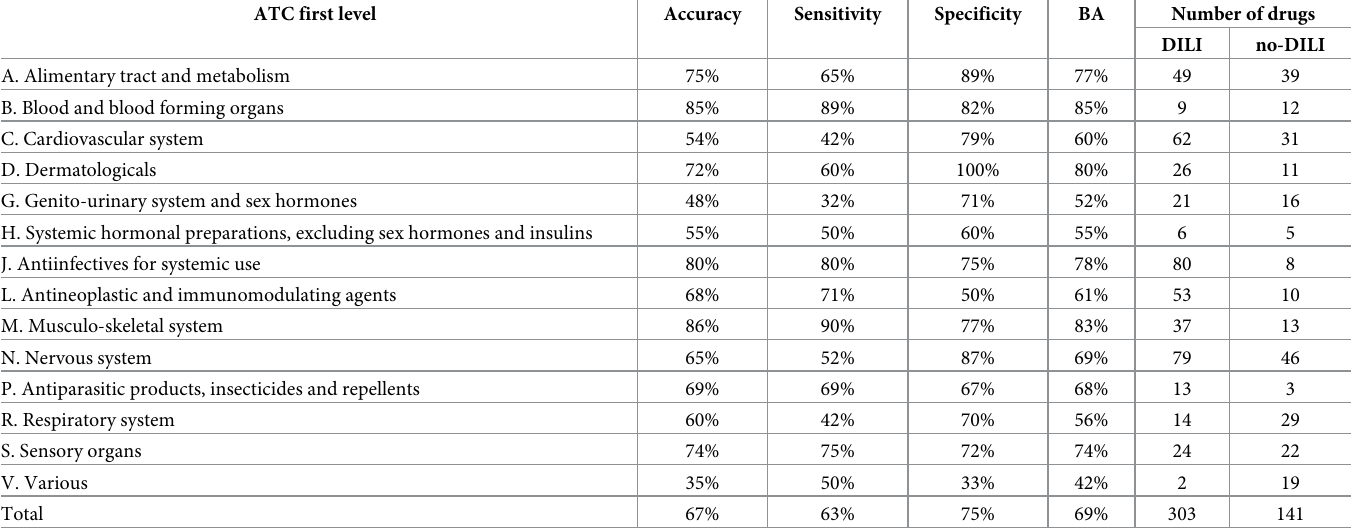
Table 4. Accuracy of discrimination using AMW by ATC first level